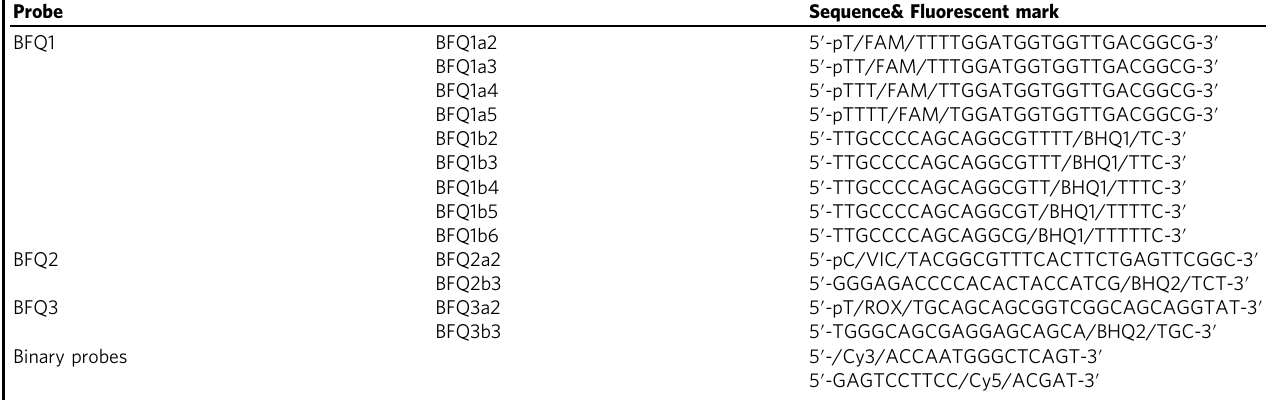
Table 1 The fl uorophore-labeled single-stranded DNA probes used in this study.